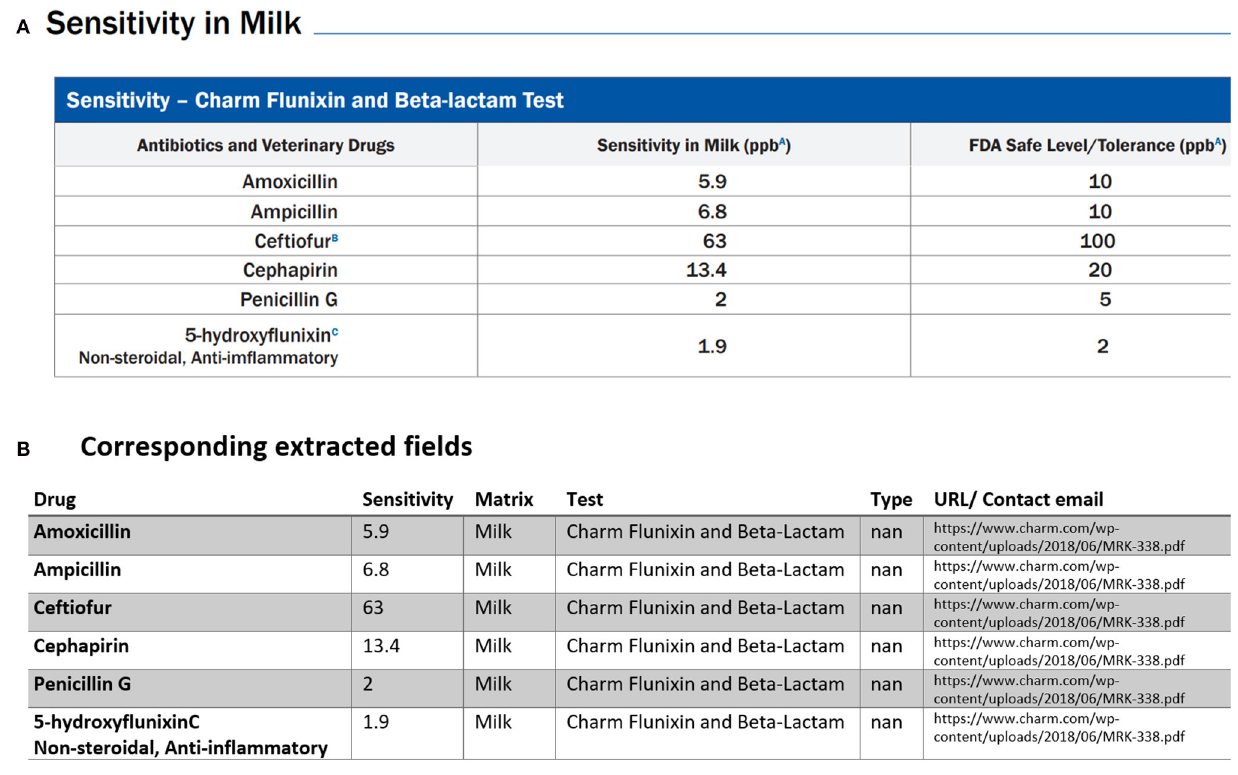
FIGURE 5 | An example of data table extraction for “Charm 3 SL3 Beta-Lactam” and the corresponding fields cleaned in a table where the information for Penicillin G in the last row was not extracted initially from our data collection. lists of information in tables or inadvertent run-on